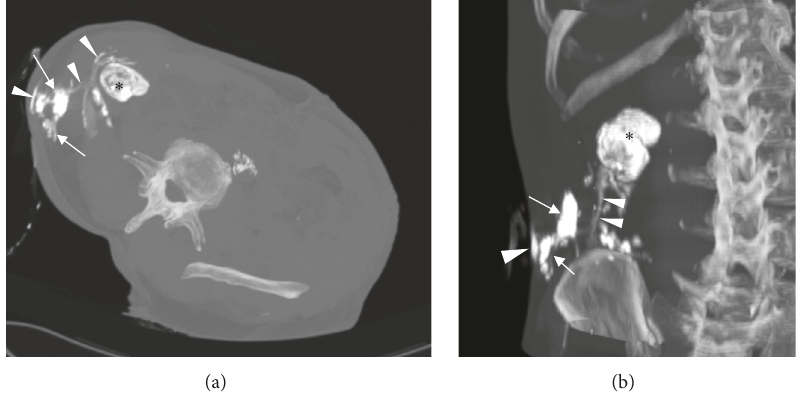
Figure 3: Axial oblique (a) and coronal (b) MIP reformatted CT-fistulography. The injection of the contrast agent through the external opening of the fistula allowed identifying the abscess (arrows) and the whole fistulous tract (arrowheads) ascending to the hepatic hydatid cyst (black asterisk)